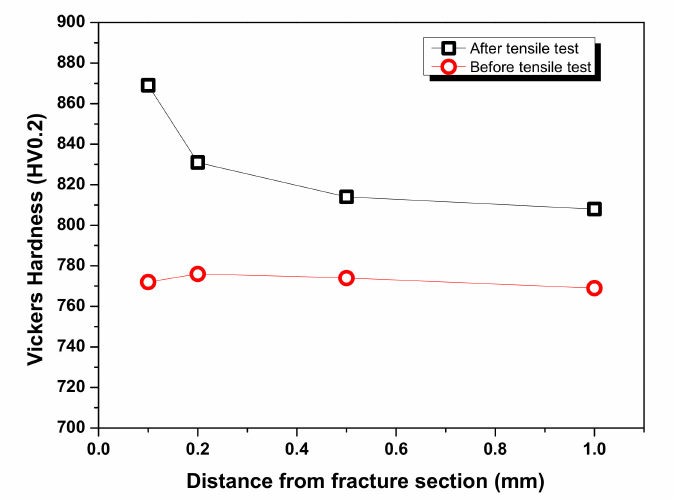
Figure 10. The Vickers hardness distribution for the carburized case of the specimens austenitized at 900 ◦ C before and after the tensile